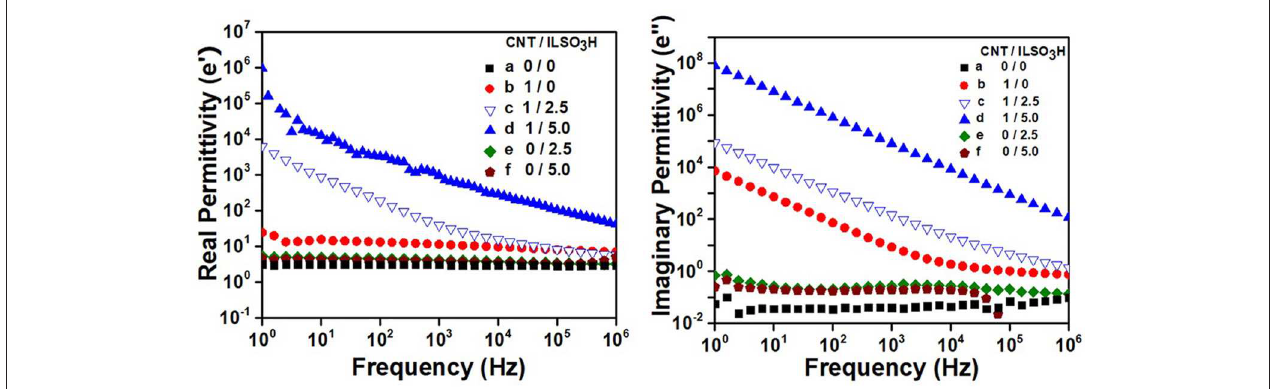
FIGURE 9 | Dielectric properties of PLA/EVA blends containing CNT/ILSO 3 H in a proportion of (a) 0:0; (b) 1:0; (c) 1:2.5; (d) 1:5; (e) 0:2.5; and (f) 0:5